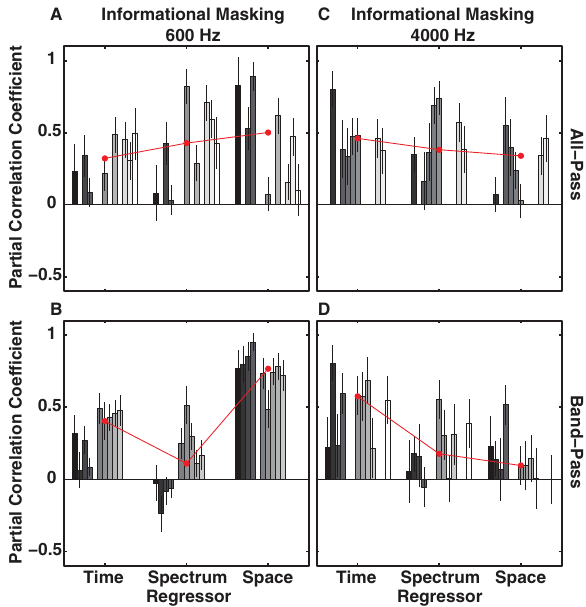
Figure 7. Partial correlation coefficients (weights) for regres- sors temporal onset (time), masker type, i.e. iC and iR (spectrum), and spatial separation between signal and masker (space) as obtained by multiple linear regression. Results for the 600-Hz (A, B) and 4000-Hz (C, D) signal with informational all-pass (A, C) and band-pass (B, D) maskers for individual subjects (bars in different shades of gray) are shown. Error bars indicate 95% CIs and the red line with circular markers depicts the median across all subjects. Values close to 1 (0) indicate a strong positive (weak) weight of a given regressor. Subject order as in Fig.